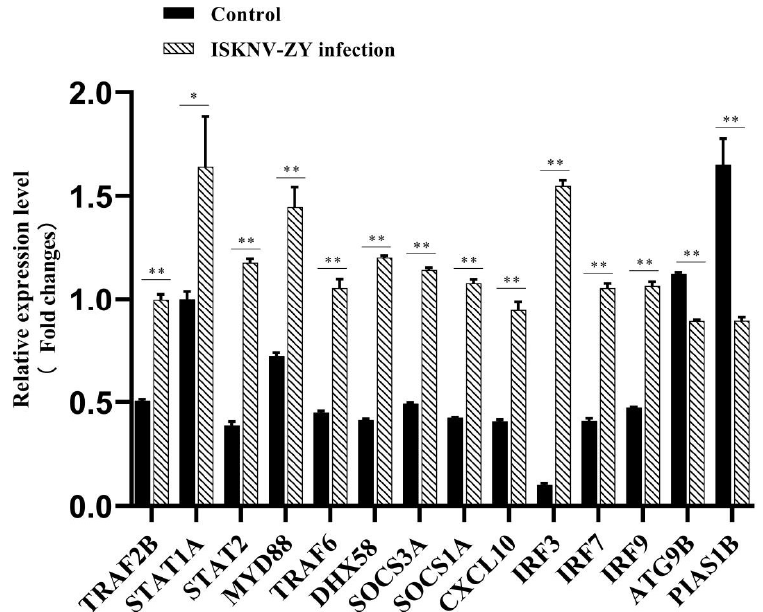
Figure 7. Relative expression levels of 14 genes in largemouth bass infected with infectious spleen and kidney necrosis virus (ISKNV)-ZY. The fold change in the expression of the 14 selected upregulated and downregulated differentially expressed unigenes (DEGs) was validated using qRT-PCR upon ISKNV-ZY infection. Data are expressed as log2 (fold change) relative to β -actin. p -values of * <0.05 and ** <0.01 were considered statistically significant.